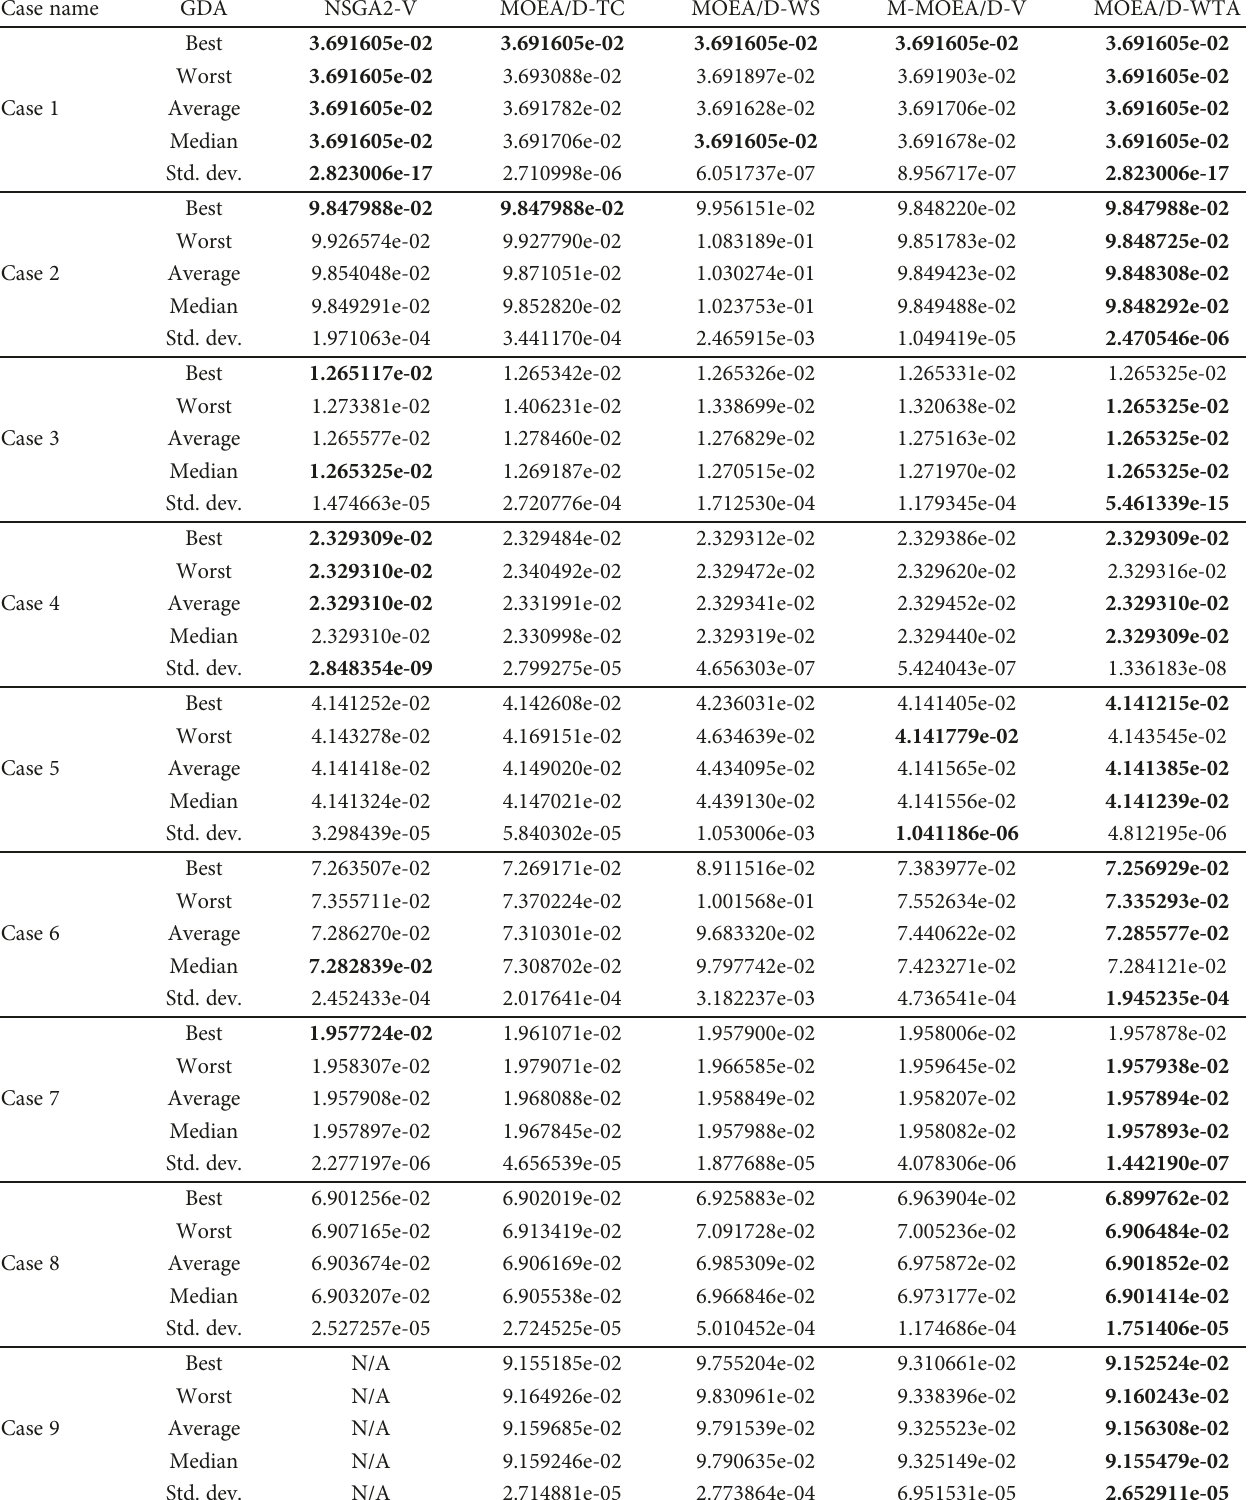
Table 3: Results of the GDA metric for the comparison algorithms (N/A indicates that the result is not available within the acceptable time